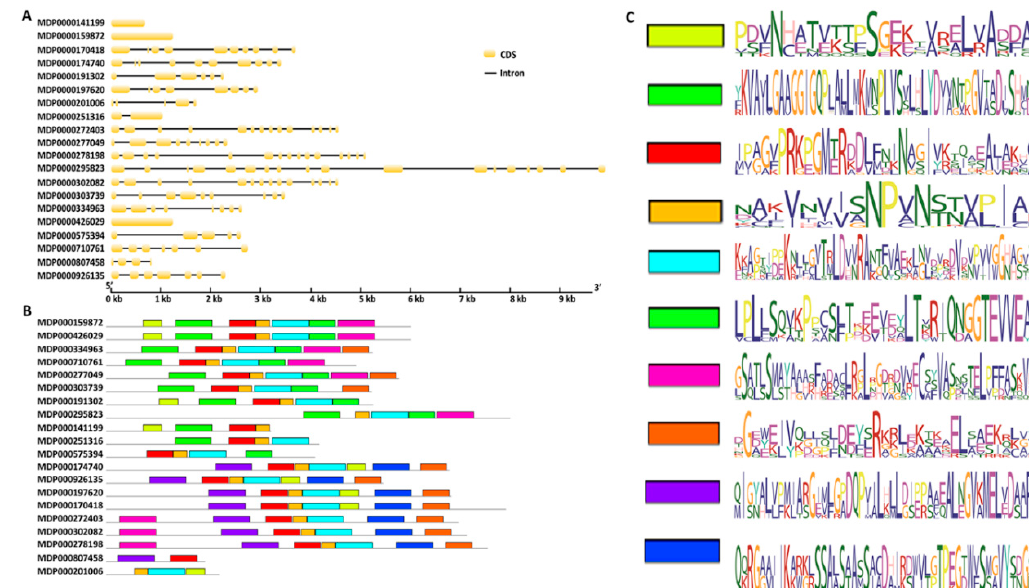
Figure 1. The genomic structure and conserved motifs of MDH genes in apple: ( A ) the exon–intron structure of apple MDH genes, where yellow indicates exons and black line indicates introns; ( B ) the distribution of conserved motifs in MdMDH proteins, where the conserved motifs are indicated by colored boxes; and ( C ) sequences of the 10 conserved motifs in MdMDH proteins identified in this study.